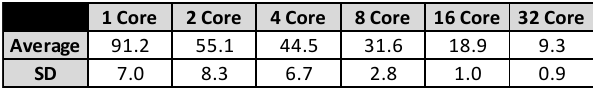
Table 5: Intel Prototype Host CPU %